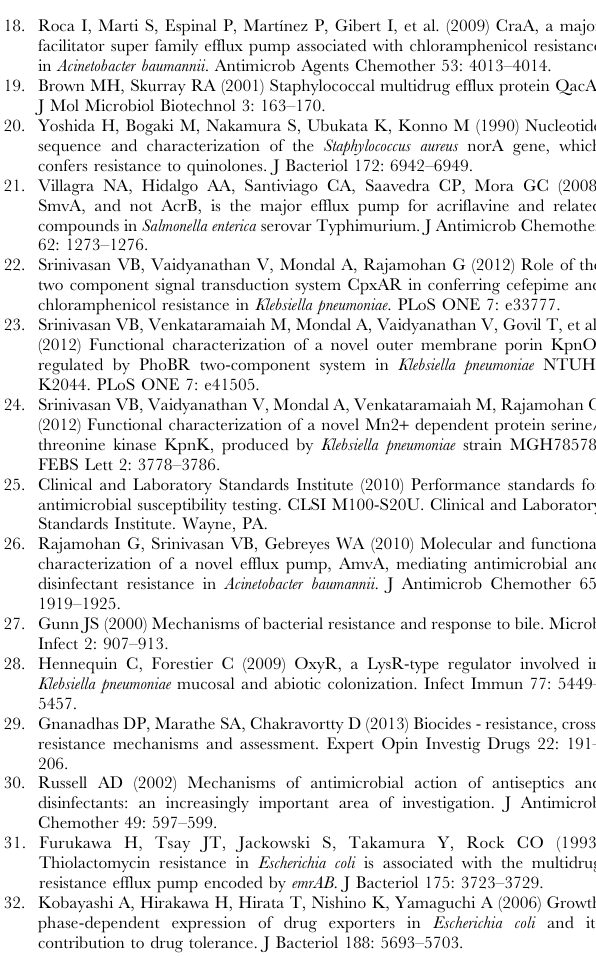
Figure S5 Protein profiling of WT and kpnGH mutants. Membrane protein profiles were compared between the